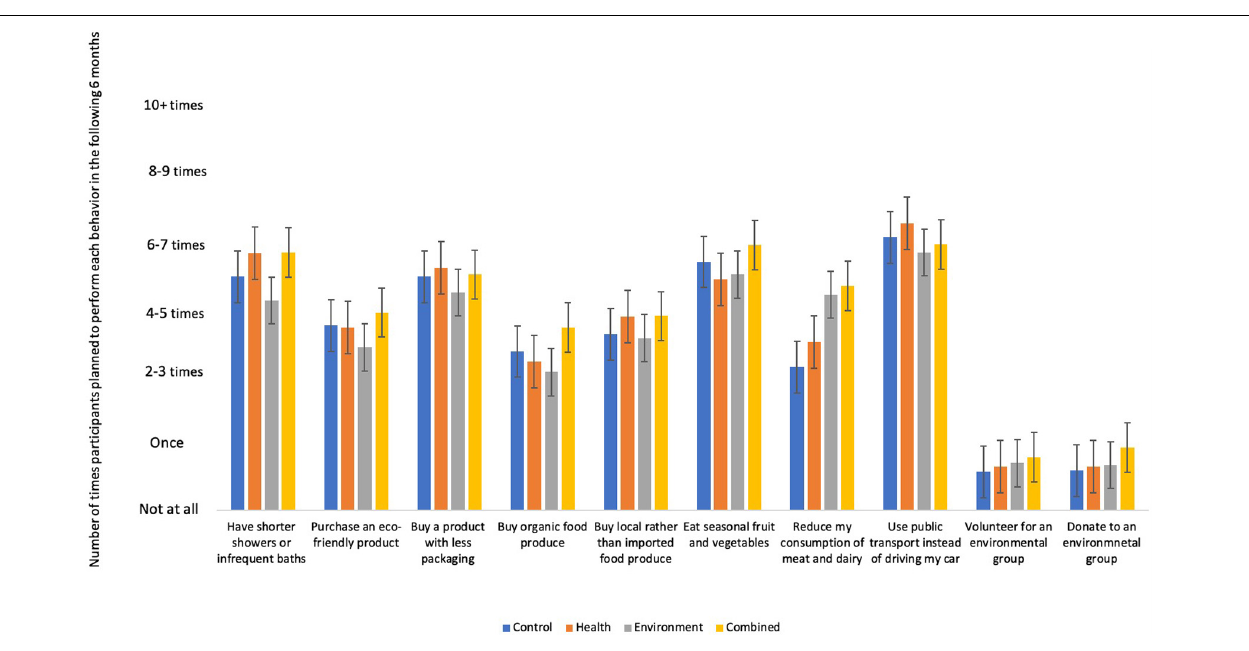
variables. Analysis was first conducted to investigate behavioral spillover at T2. Multiple linear regressions were conducted with change in red and processed meat consumption (T2–T1) and